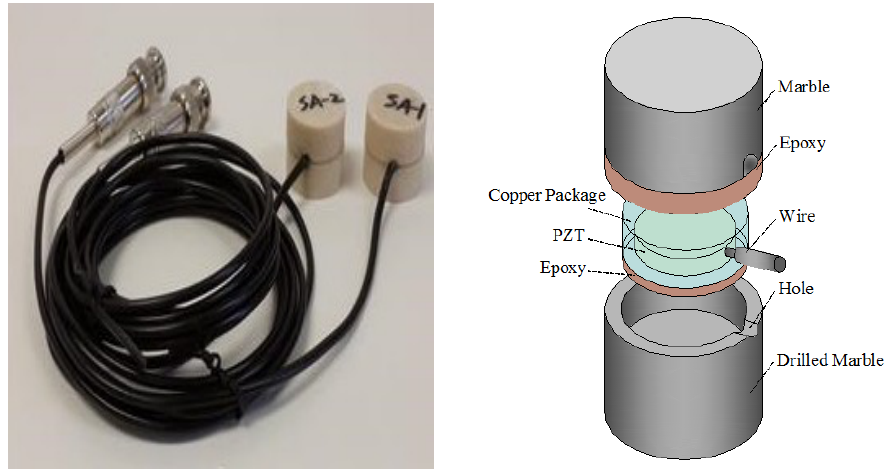
Figure 2. Illustration of smart aggregates [9].